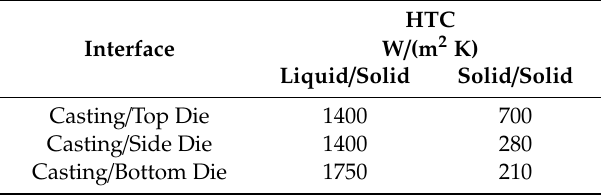
Table 3. HTCs specified for the casting / die